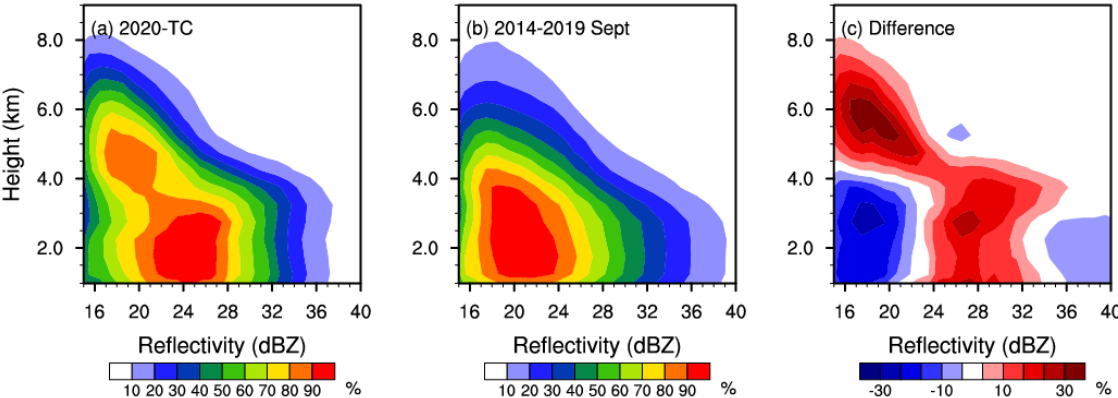
Figure 4. CFADs for the reflectivity during the ( a ) 2020-TC period, ( b ) September 2014 – September 2019 period, and ( c ) their difference (former minus the latter). The CFADs are normalized by the overall maximum, and the value of each bin represents the occurrence frequency compared to the absolute maximum frequency.